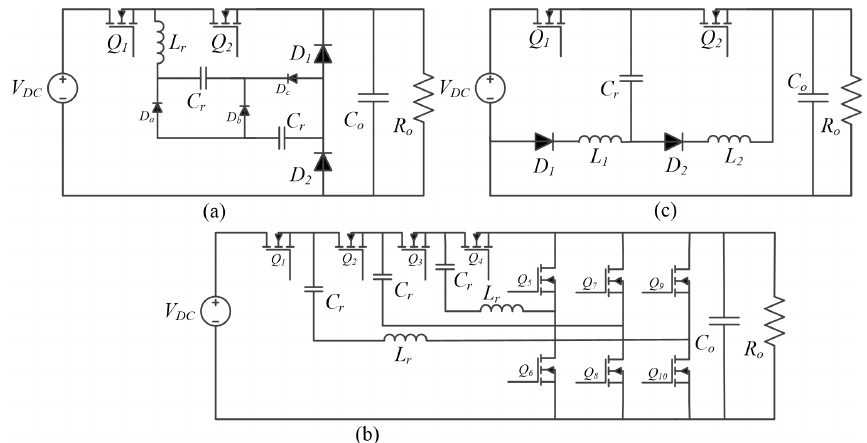
Figure 6. Switched resonator converters; ( a ) basic form, ( b ) switched-tank converter (STC) and ( c ) SwRC having multi-mode